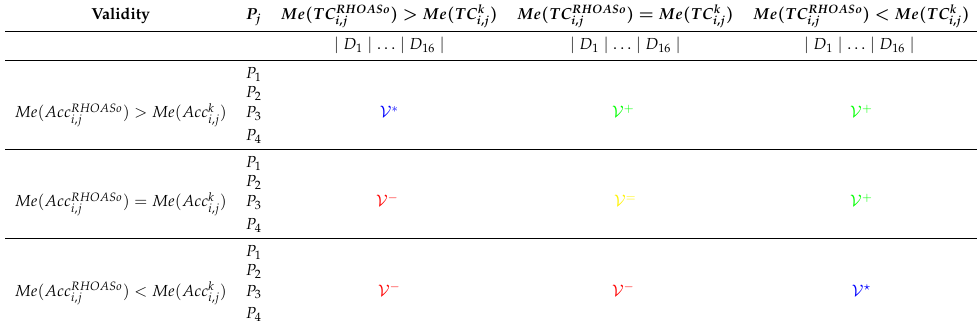
Table 6. Conditions of validity. The symbols = , > , < denote statistically meaningful equality and difference, and Me denotes the